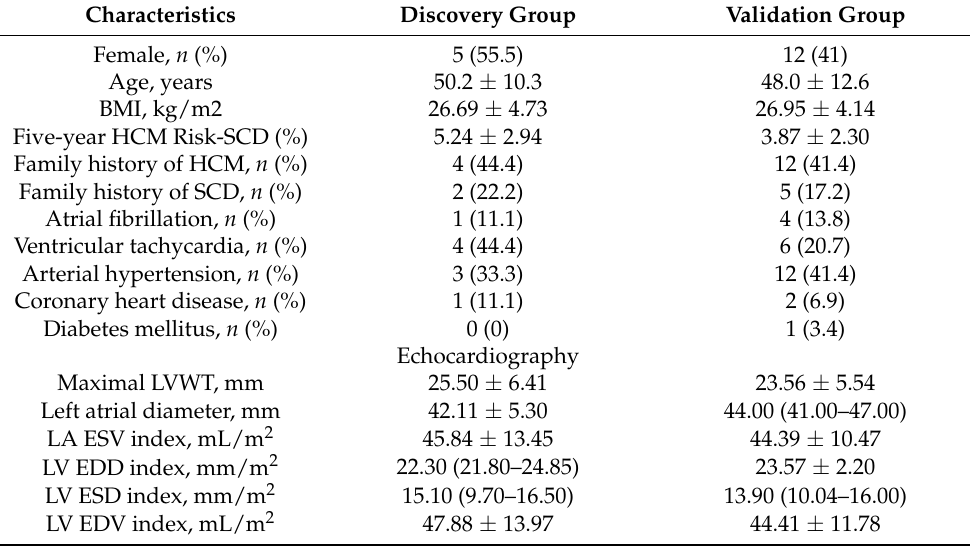
Table 1. Clinical characteristics of HCM patients involved in the study ( n =